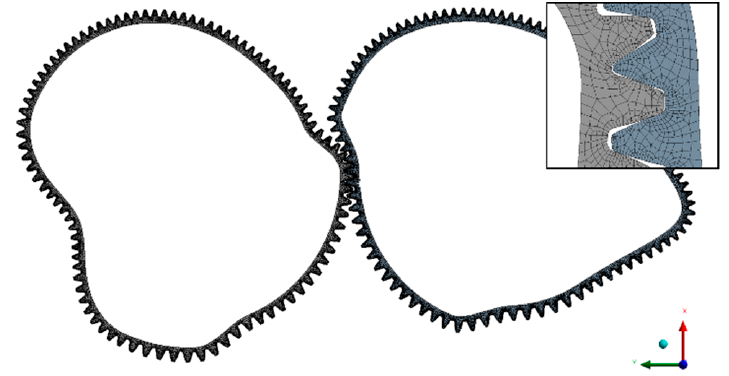
Figure 13. Generation mesh data of non-circular gear.